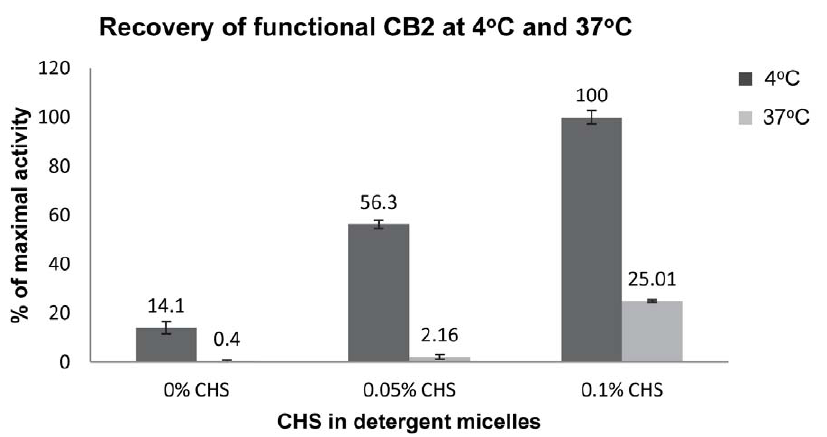
Figure 5. Effect of CHS on stability of CB 2 in detergent micelles at 4 u C and 37 u C. Activity of CB 2 recovered from micelles supplemented with 0.1% CHS at 4 u C was set as 100%. Figure presents results of a typical experiment (out of a total of 3), each point is an average of two measurements of the same sample with SD as indicated.